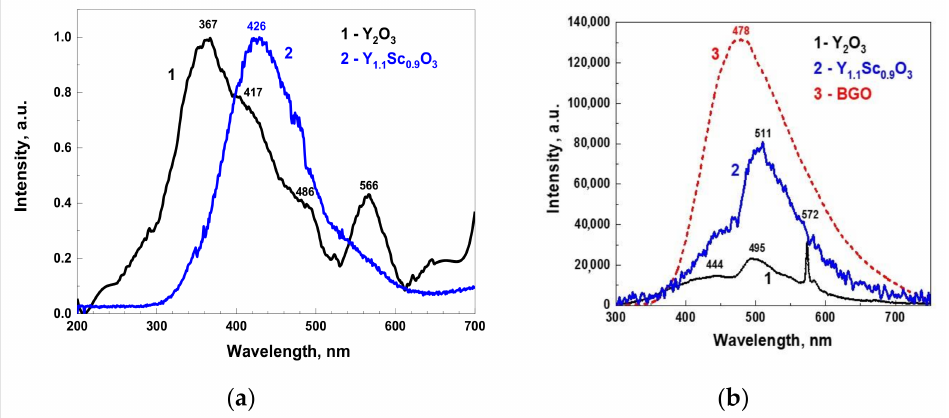
Figure 6. Normalized X-ray luminescence spectra of Y 2 O 3 and Y 1.1 Sc 0.9 O 3 ( a ); cathodoluminescence spectra ( b ) of Y 2 O 3 and Y 1.1 Sc 0.9 O 3 in comparison with the BGO reference